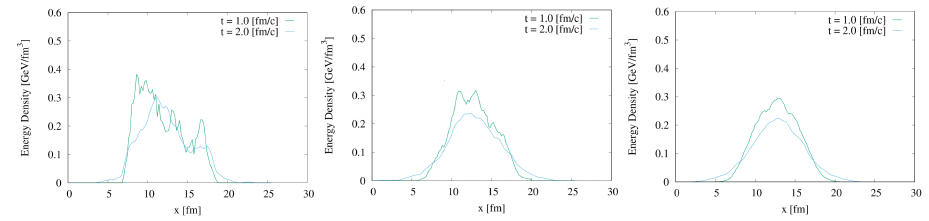
Figure 1. Energy density projection in 1D (y = z = 12.8 fm)